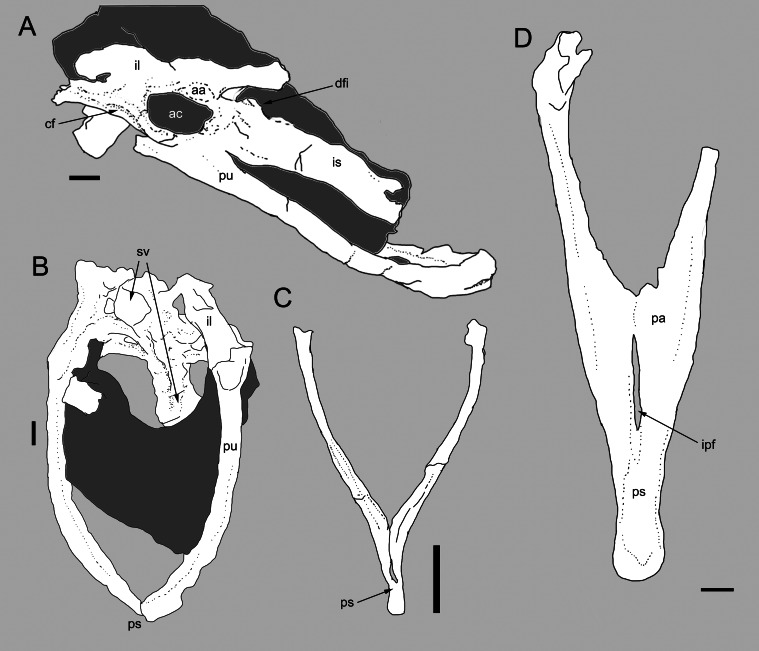
Comparison between the pelvis of Balaur and other paravians.Pelvis of Balaur in lateral view (A). Comparison of the pubes of Balaur in anteroventral view (B) to those of the pygostylian Sapeornis in anterior view (C), and the dromaeosaurid Velociraptor in posterior view (D). (C) after Zhou & Zhang (2003, Fig. 8); (D) after Norell & Makovicky (1999, Fig. 19). Scale bar: 10 mm (A, B, D), 2 mm (C). Abbreviations: aa, antitrochanter; ac, acetabulum; cf, cuppedicus fossa; dfi, dorsal flange of ischium; ipf, interpubic fenestra; is, ischium; pa, pubic apron; ps, pubic symphysis; pu, pubis, sv, sacral vertebrae.